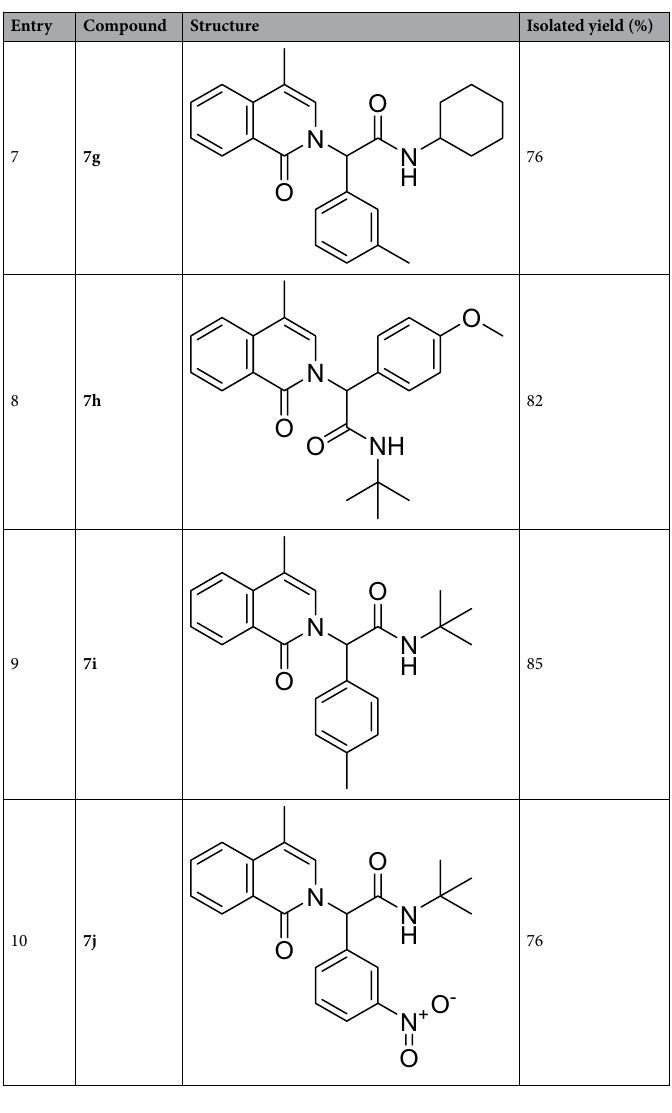
Table 2. Optimization conditions of the synthesis of N -cyclohexyl-2-(4-methyl-1-oxoisoquinolin-2(1 H )- yl)-2-phenylacetamide. Reaction conditions: Compound 6 (0.3 mmol), potassium carbonate (0.6